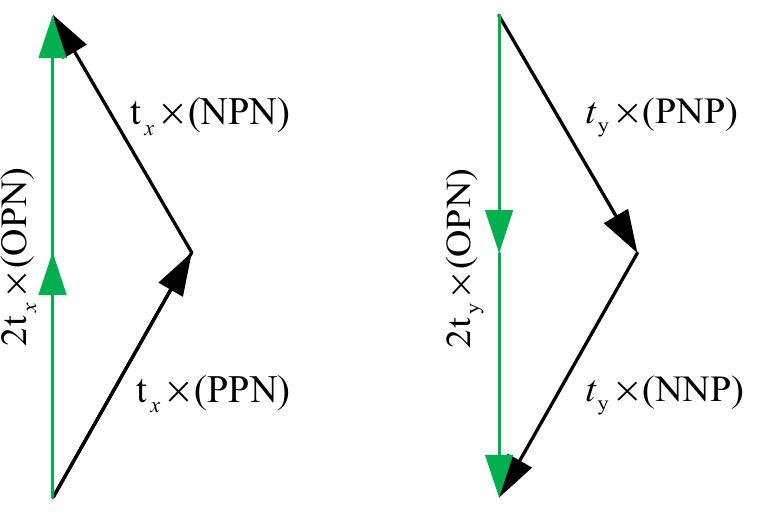
Figure 7. Vector synthesis diagram.